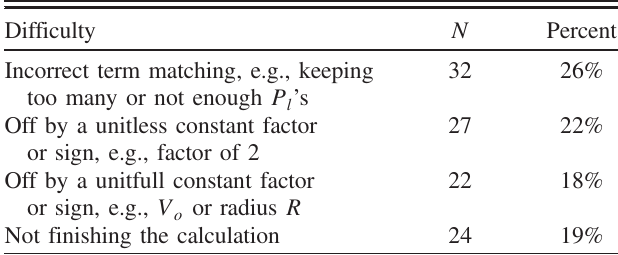
TABLE V. Common difficulties when executing the procedural mathematics of solving for constants in the general solution. Percentages are of just the students who exhibited these diffi- culties (27%, N ¼ 125 of 469). Codes are not exhaustive or exclusive but represent the most common themes; thus, the